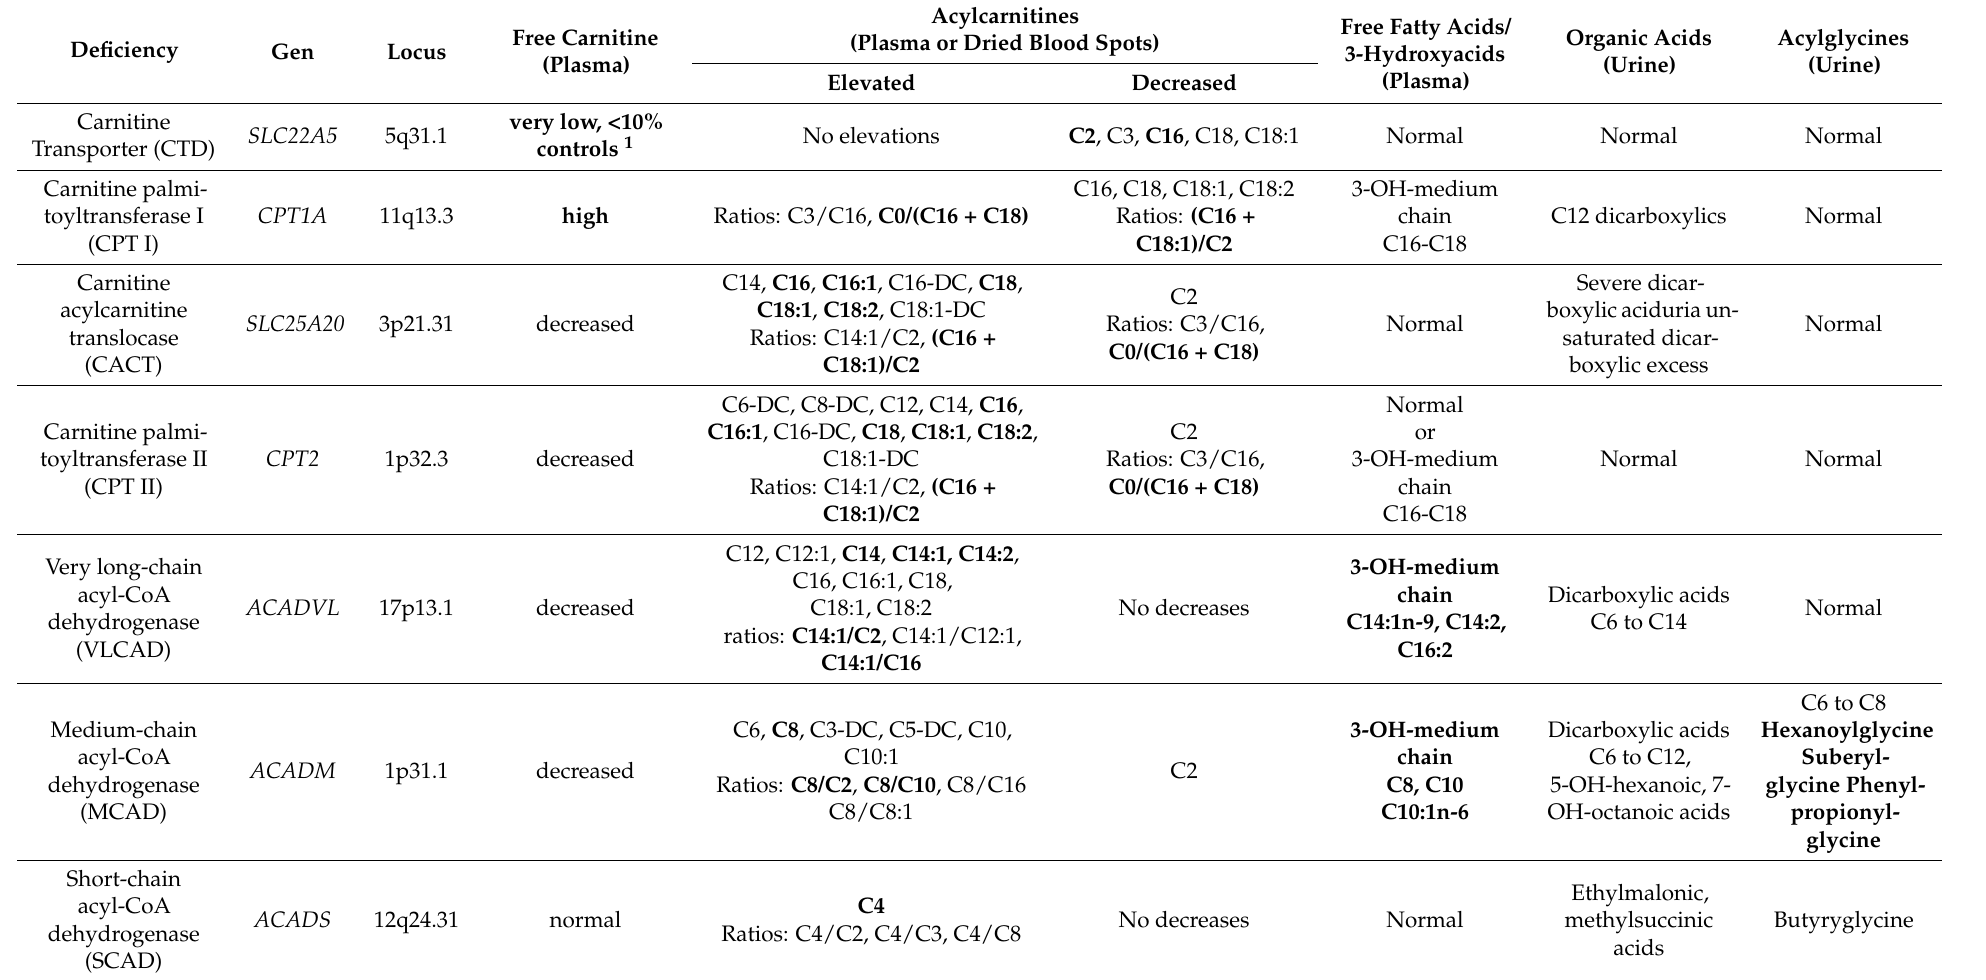
Table 2. Biochemical markers and chromosomal location in mitochondrial ß-oxidation and carnitine system